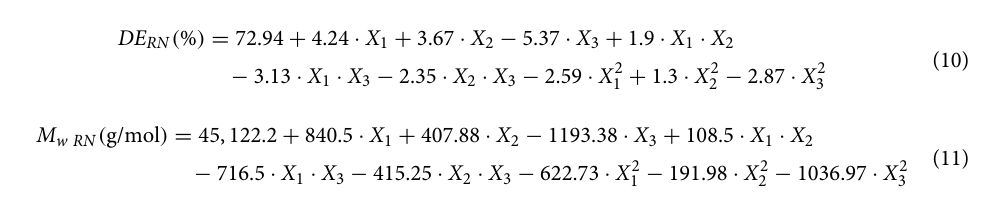
11.23% for similar extraction conditions.